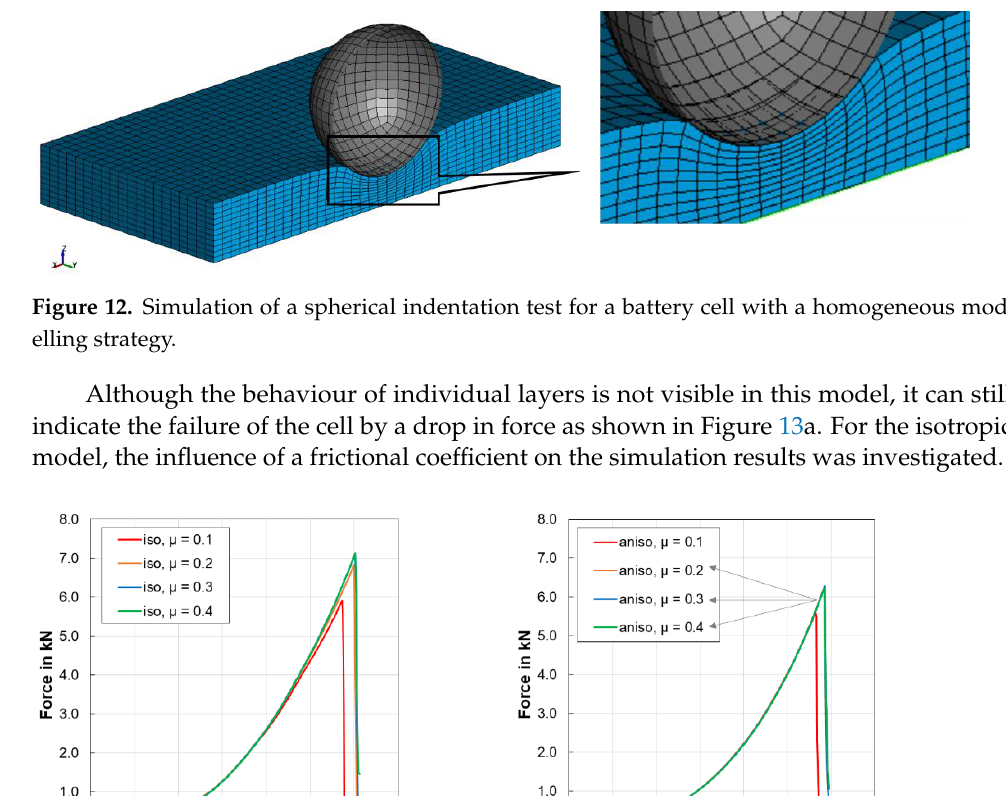
( b ) Figure 11. ( a ) Stress distribution on a deformed battery cell after indentation simulation. ( b ) Force- displacement outputs of isotropic and anisotropic models with the heterogeneous modelling method. For similar simulation settings i.e., with 40% failure strain, initially there was no drop observed for the anisotropic separator model. The increase in force was also less than that of the isotropic separator model. The simulation was completed in 95 h. To achieve closer behaviour, the failure strain of the separator was reduced by 10%. The newly selected value of the failure strain of 0.3 or 30% is still within the range of values documented in